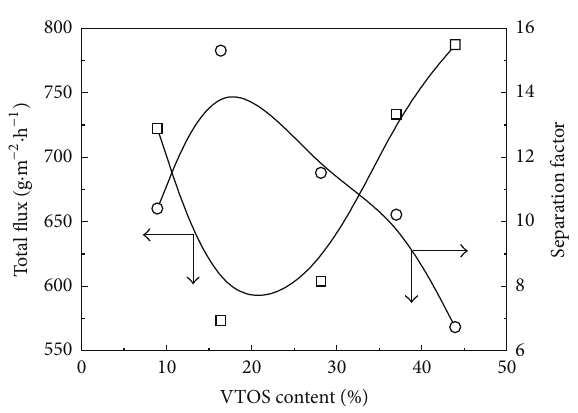
Figure 7: The effect of VTOS content on pervaporation properties of PDMS-VTOS membrane (feed concentration is 6wt%, the cross- linking temperature is 80 ∘ C, and the PV temperature is 60 ∘ C).